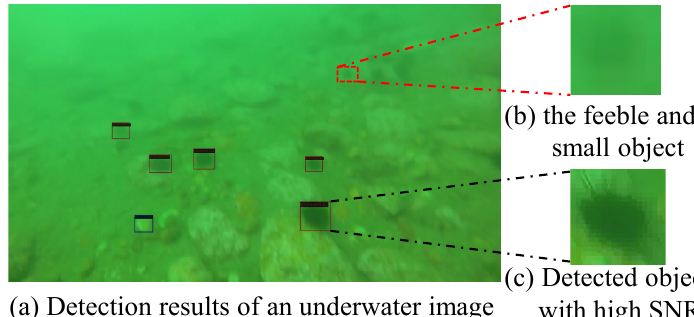
Figure 1. Feeble and small objects in the underwater image. The image appears severely degraded, showing low contrast, non-uniform illumination, and blurring: ( a ) shows the detection results, ( b ) shows the feeble and small object that is hard to detect, where the object’s SNR is − 3.7 dB, and ( c ) shows the object with SNR equal to − 2.7